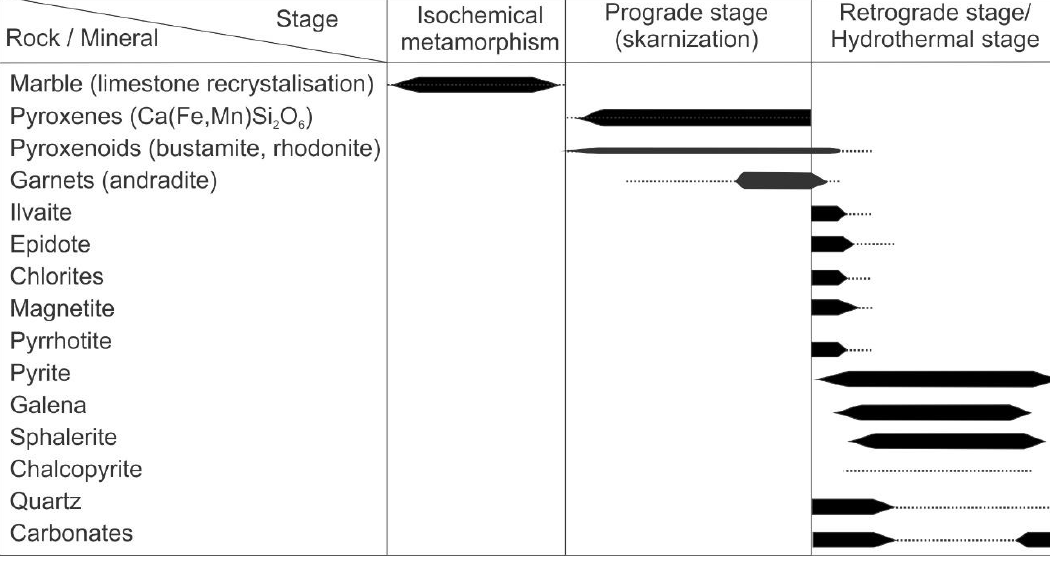
Figure 4. Paragenetic sequence of the Sasa Pb-Zn-Ag skarn deposit.